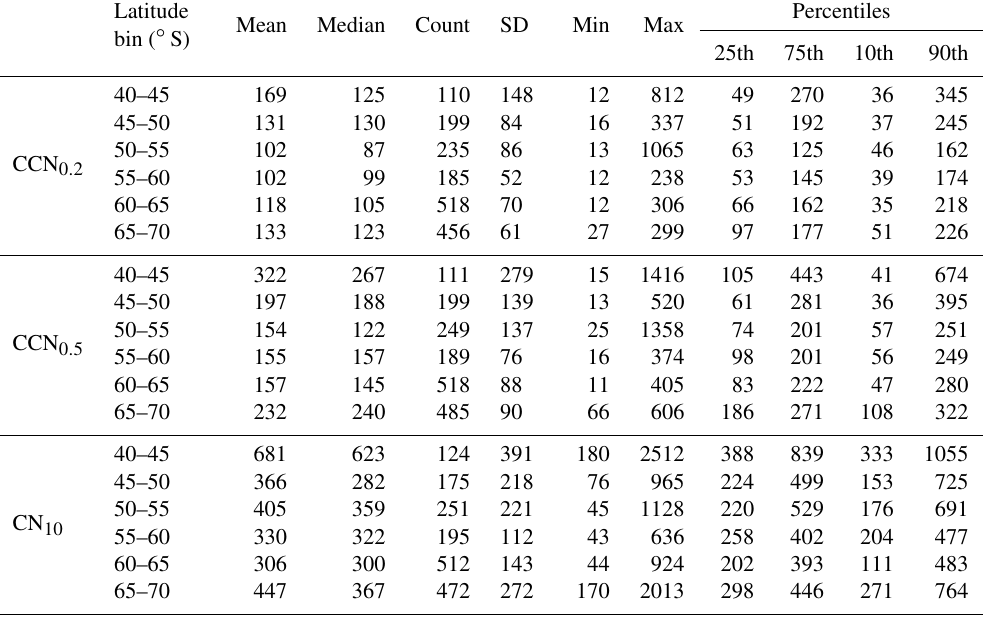
Table A1. Statistics for CCN 0 . 2 , CCN 0 . 5 and CN 10 for each of the latitude bins using data from both MARCUS and